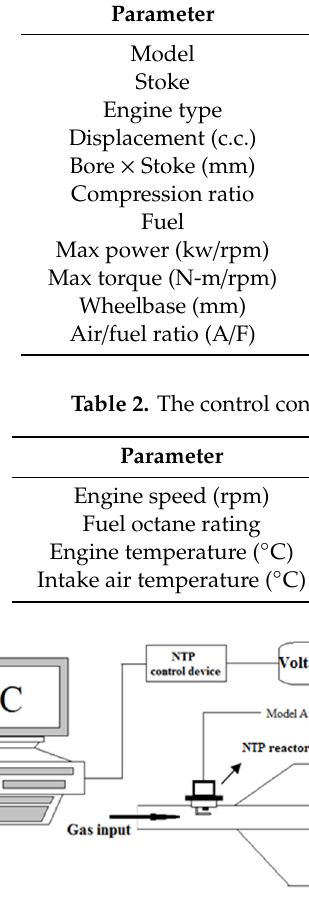
Figure 2. The setup of non-thermal plasma (NTP) system.